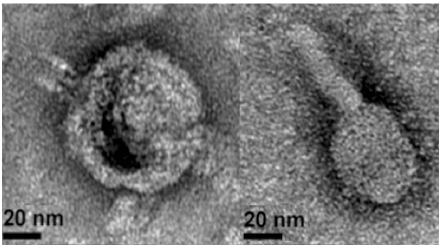
Figure 2. Representative transmission electron microscopy (TEM) images of mitomycin C-induced phages recovered from the supernatant of S. fidelis 3313.